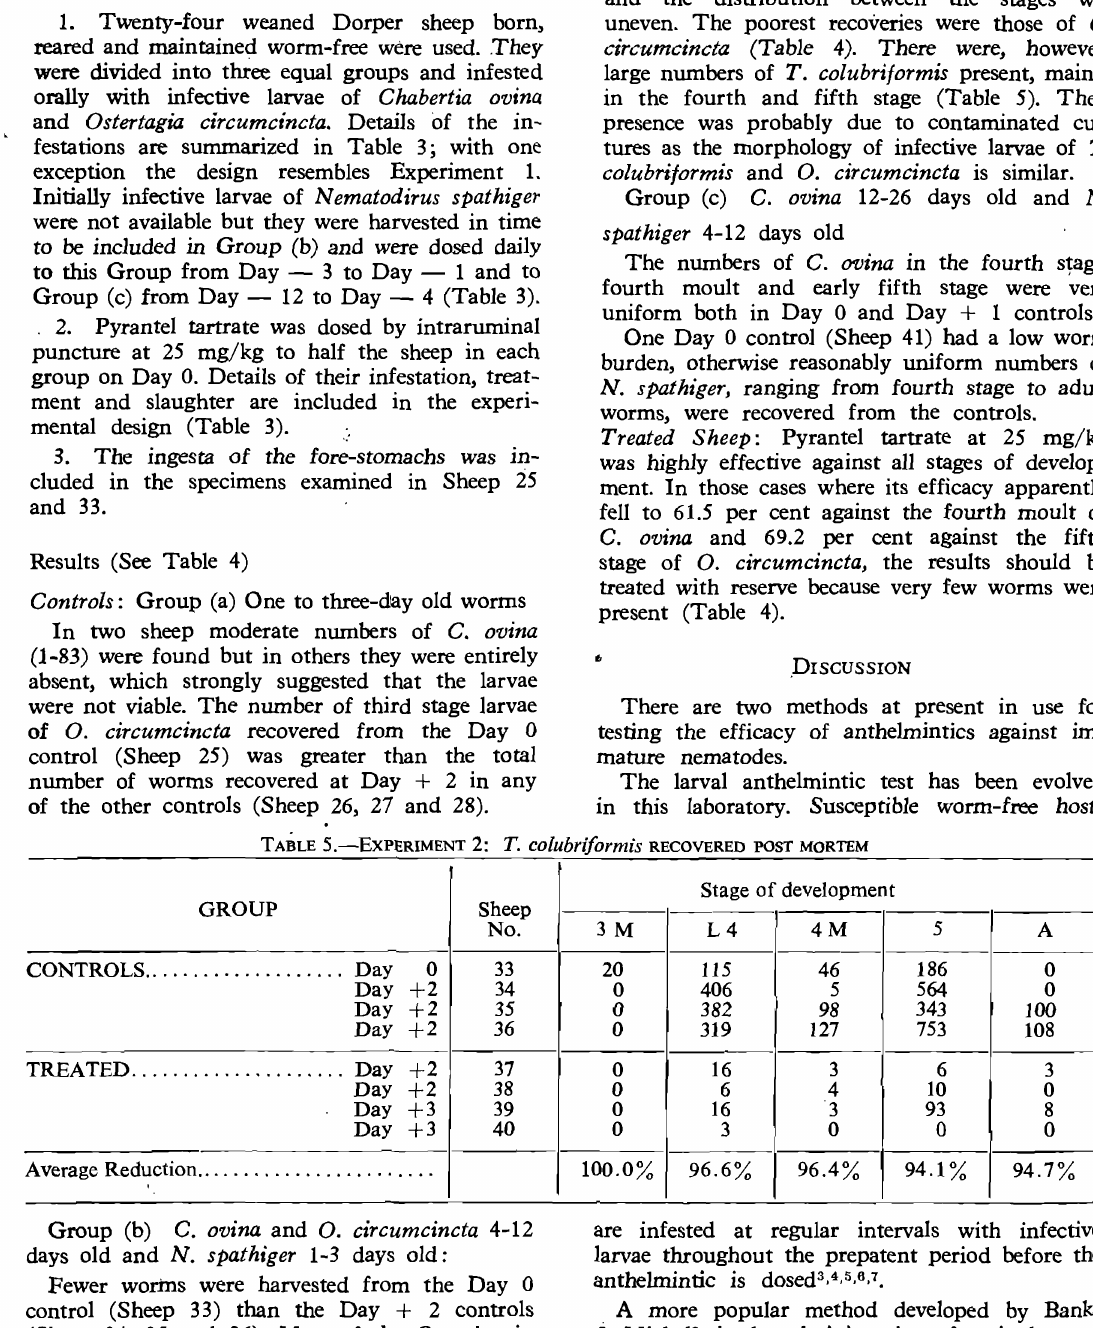
TABLE 5.-ExPERIMENT 2: T. colubri/ormis RECOVERED POST MORTEM